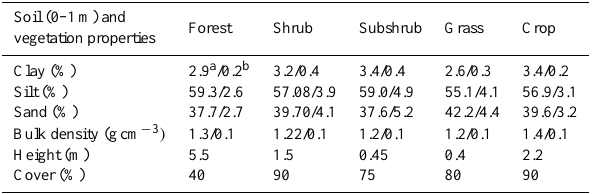
Table 1. Main characteristics for different land cover